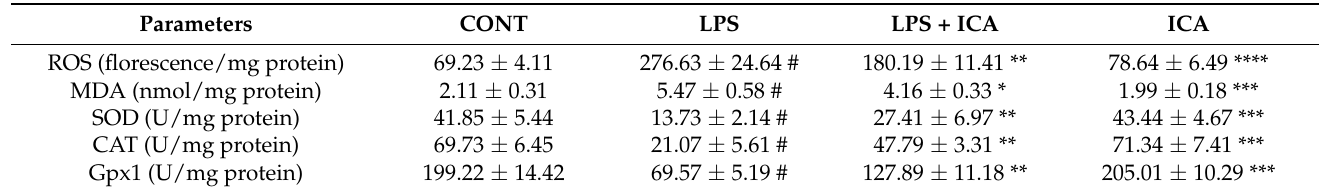
Table 1. ICA administration mitigated LPS-induced oxidative stress in uterine tissue of mice. Parameters